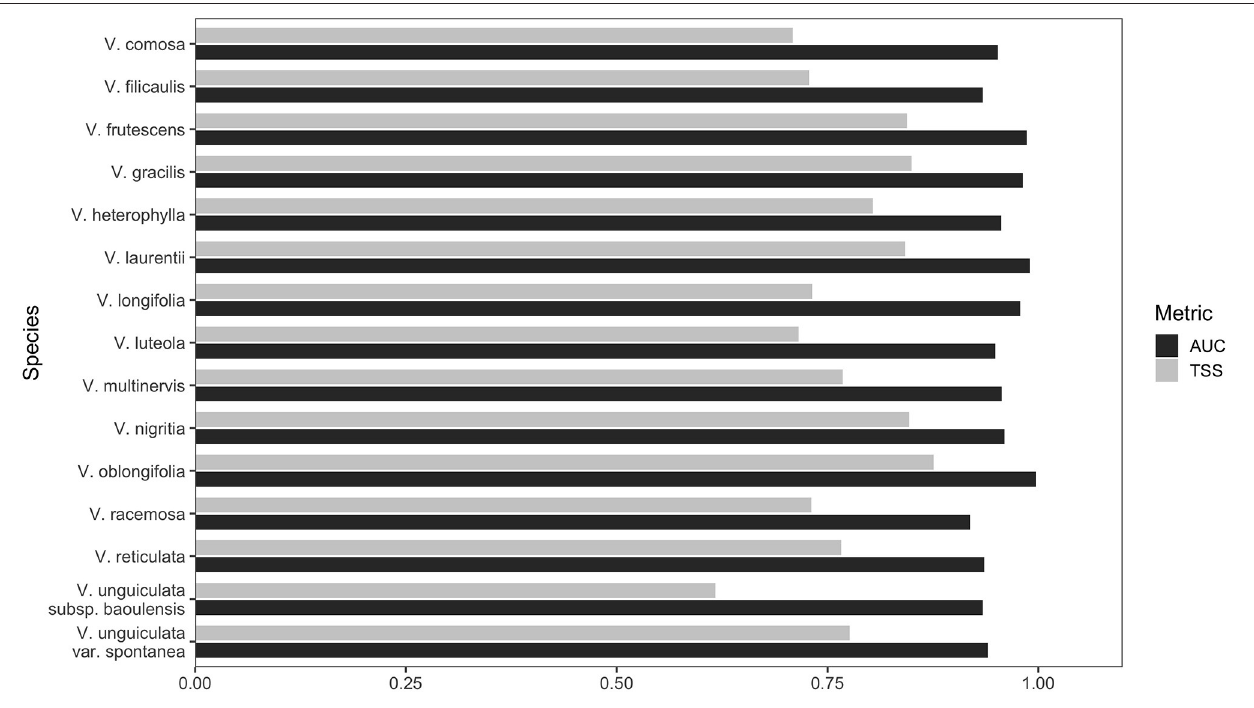
FIGURE 2 | Graph of the AUC and TSS values of the modelled 15 Vigna CWR taxa in Benin.